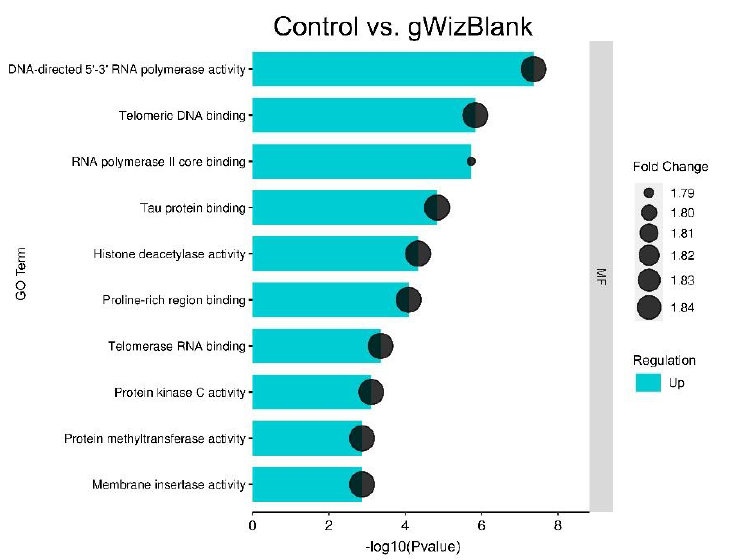
Figure 3. Enriched GO molecular function terms in tumors injected with pDNA when compared to controls. The plot shows the GO molecular function terms plotted in order of significance.